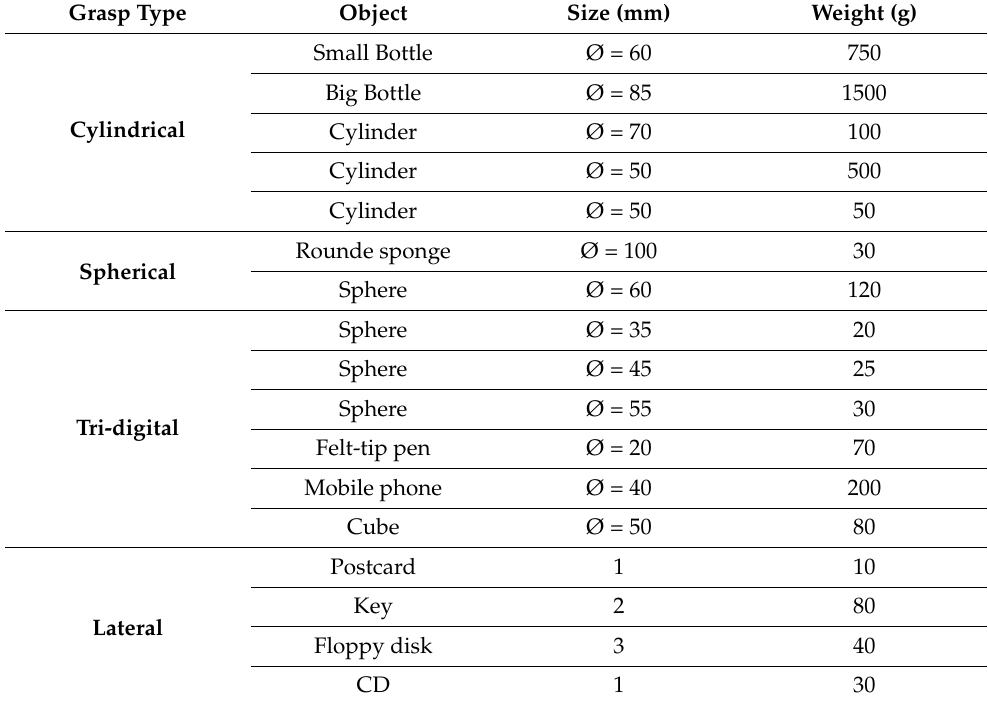
Table 2. Grasp type and objects involved during the tests